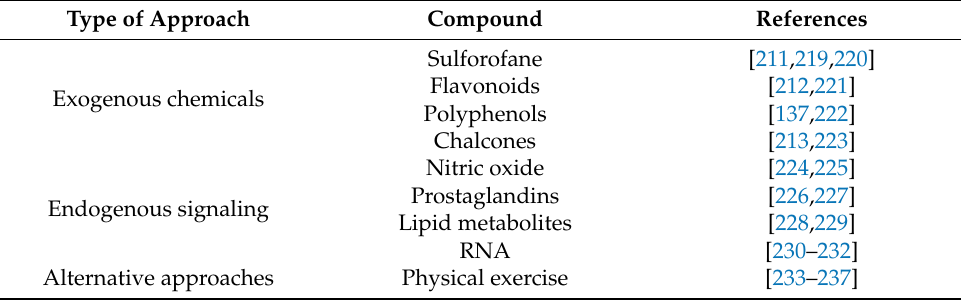
Table 1. NRF2 modifiers assayed for PD